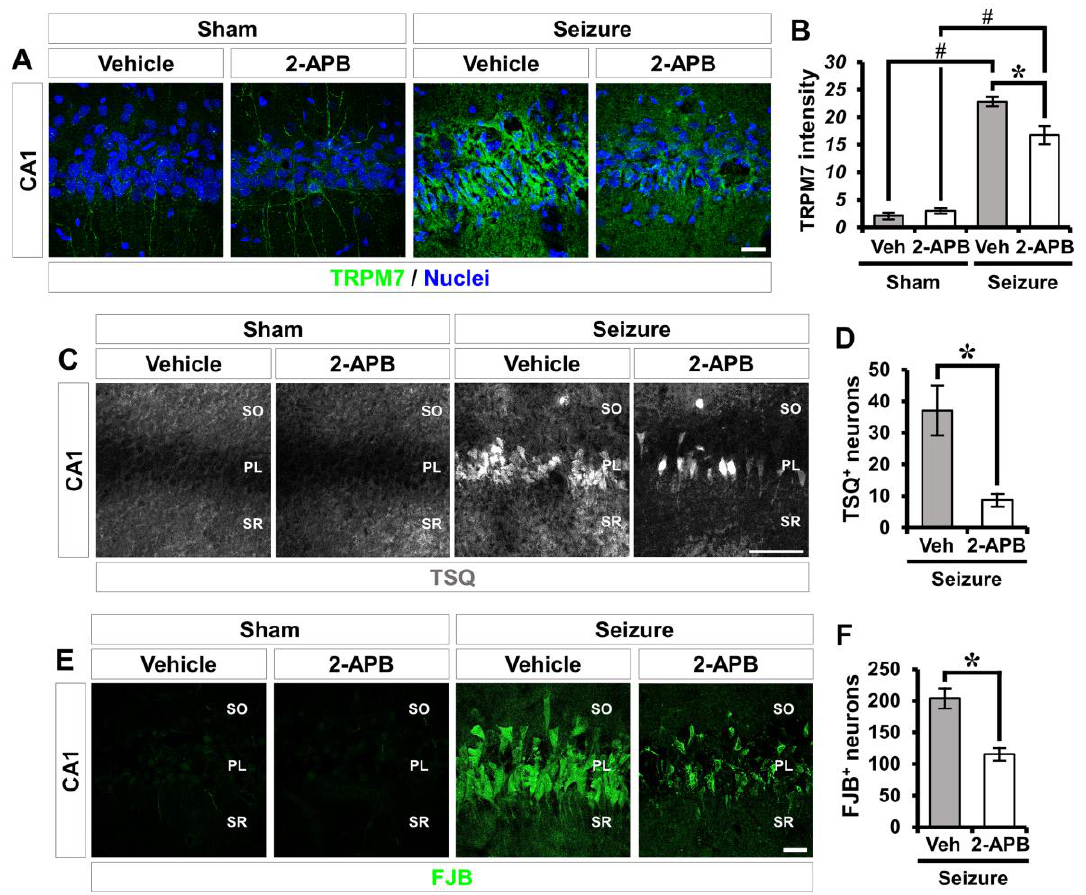
Figure 7. 2-APB treatment reduces TRPM7 overexpression, zinc accumulation, and neuronal degeneration after seizure. ( A ) Representative images showing TRPM7 immunoreactivity (green) in the CA1 of the hippocampus. Nuclei are counterstained with DAPI (blue). Scale bar = 20 µm. ( B ) The bar graph representing the immunofluorescence intensity of TRPM7 as determined in the same hippocampal region (mean ± SEM; n = 5 from each sham group, n = 5 – 6 from each seizure group). * p < 0.05 vs. the vehicle-treated group; # p < 0.05 vs. the sham-operated group (Kruskal – Wallis test followed by a Bonferroni post-hoc test: chi square = 17.451, df = 3, p < 0.001). ( C ) Representative images showing sections of the hippocampus stained with TSQ to detect zinc accumulation. Scale bar = 100 µm. ( D ) Bar graph showing the number of TSQ + neurons in the hippocampal CA1 (mean ± SEM; n = 6 from each sham group, n = 5 – 6 from each seizure group). * p < 0.05 vs. the vehicle-treated group